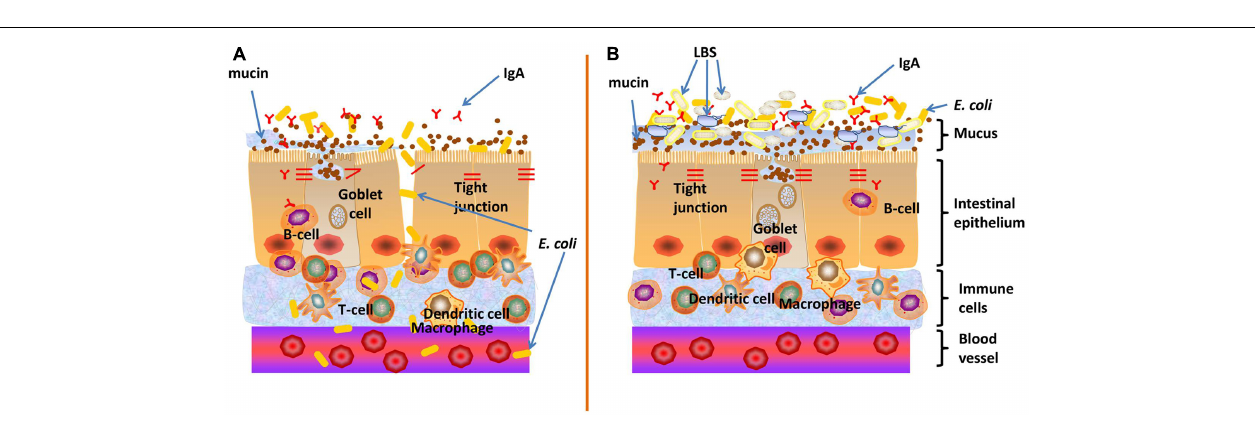
FIGURE 7 | Effects of LBS on proliferation of neonatal intestinal epithelium with or without E. coli K1 infection. Two days old neonatal rats were treated as described in Figure 5 . (A) Small intestines were processed for Ki67 immunohistochemistry. Images were visualized by light microscopy (200 × magnification). (B) Ki67-positive cells were calculated. The value of PBS group was assigned as 1. Results are represented as mean ± SD. ∗ P < 0.05, ∗∗∗ P < 0.001.